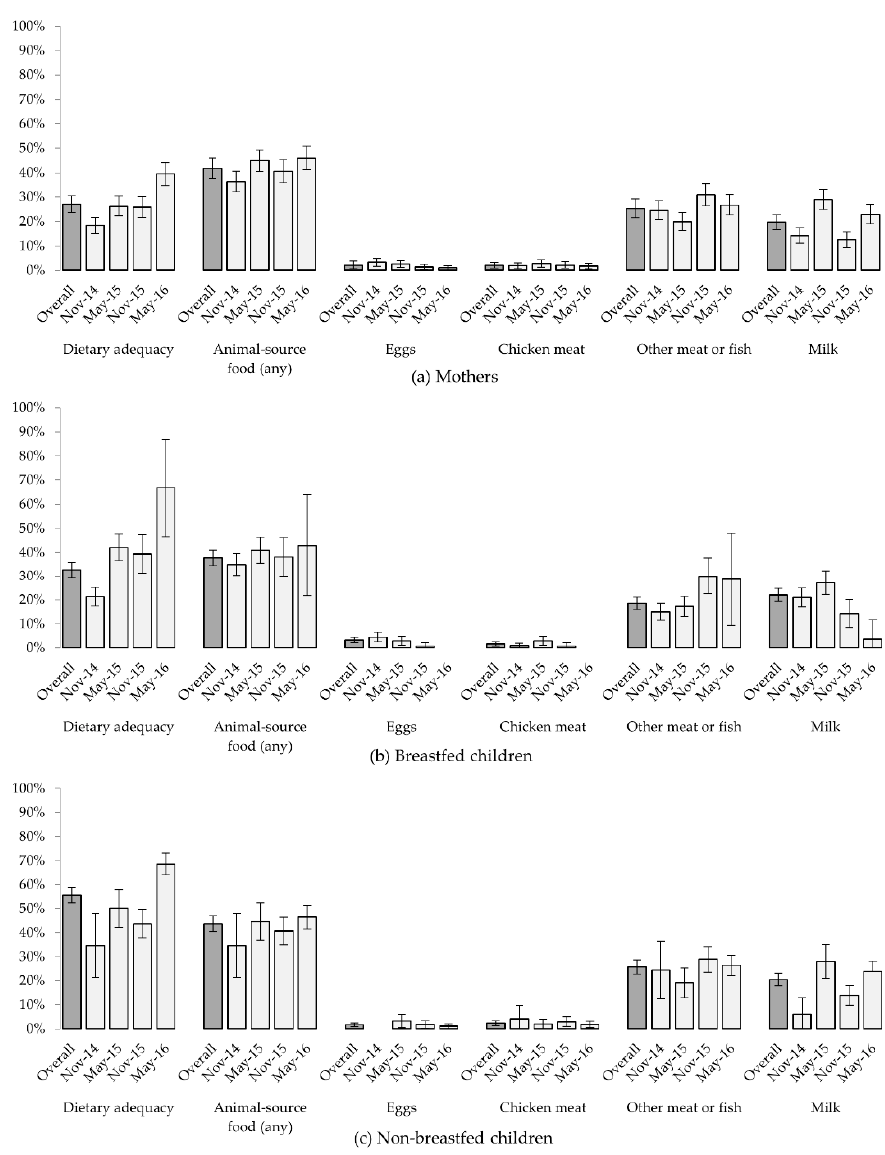
Figure 5. Percentage of ( a ) mothers, ( b ) breastfed children, and ( c ) non-breastfed children with adequate diets (according to MDD-W and IYCMDD, respectively) and consuming animal-source foods, based on six-monthly 24-h food recall, overall and for each six-monthly data collection. 95% confidence intervals are shown. Low numbers of non-breastfed children during early data collection periods, and of breastfed children later in this longitudinal study, have resulted in wide confidence intervals for some percentages reported.